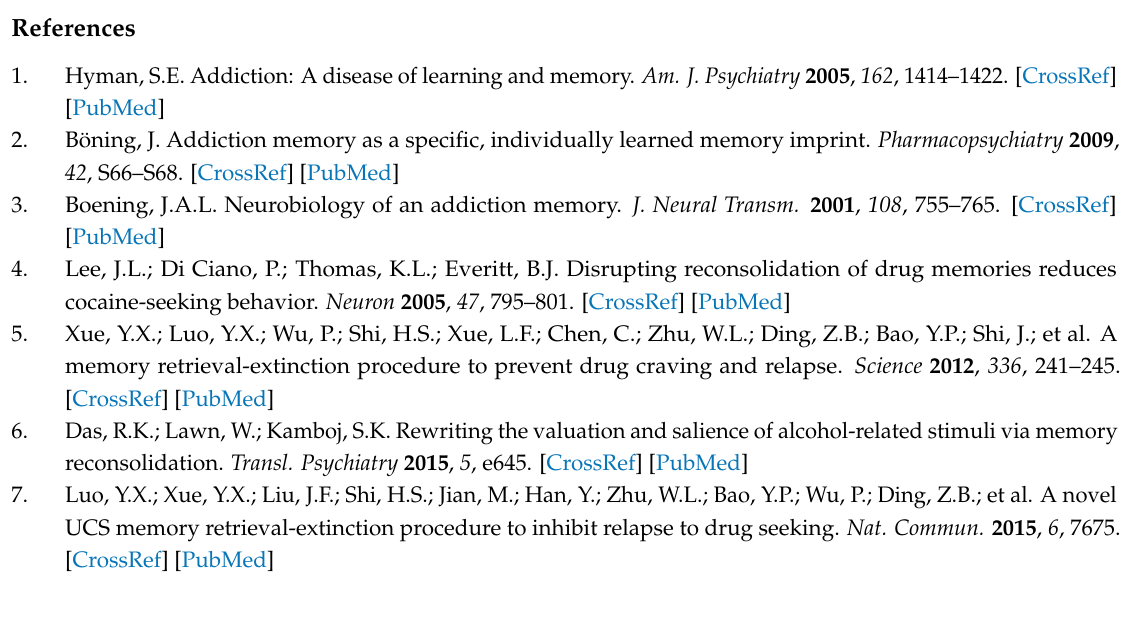
Table S1: Comparison of the participants’ characteristics in Study-2; Table S2: Factor loading and internal consistency of the Addiction Memory Intensity Scale if item-15 is deleted; Table S3: Descriptive data for measures in